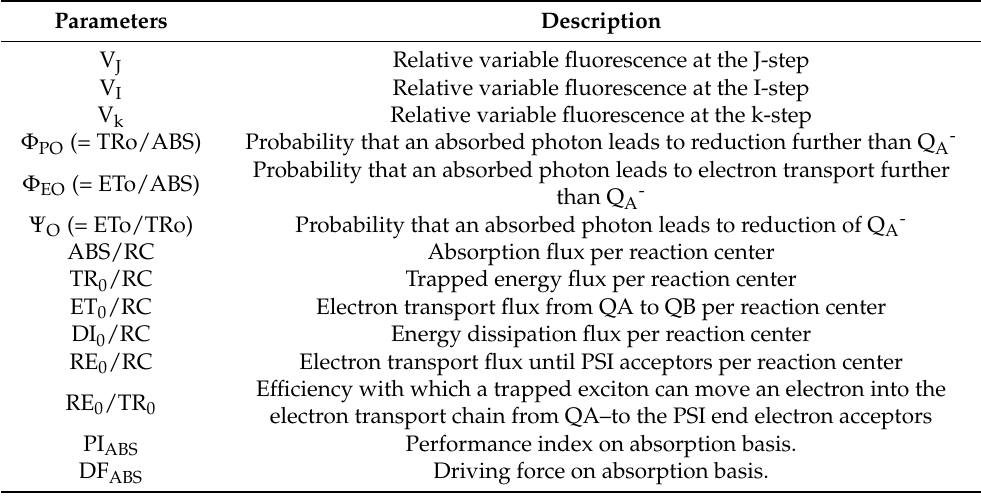
Table 3. Summary of chlorophyll fluorescence parameters from OKJIP